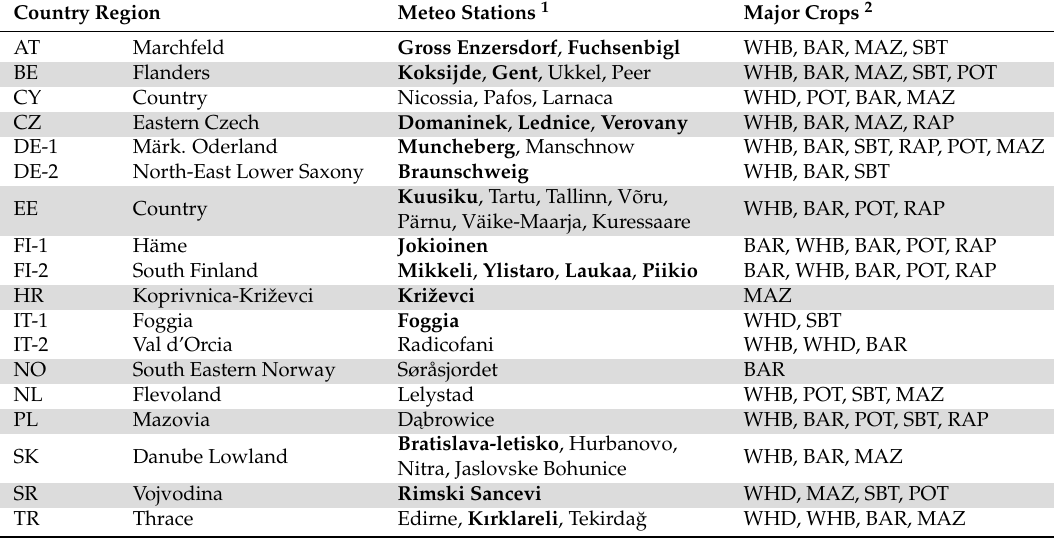
Table 1. Meteorological stations and crops per region (Location see Figure